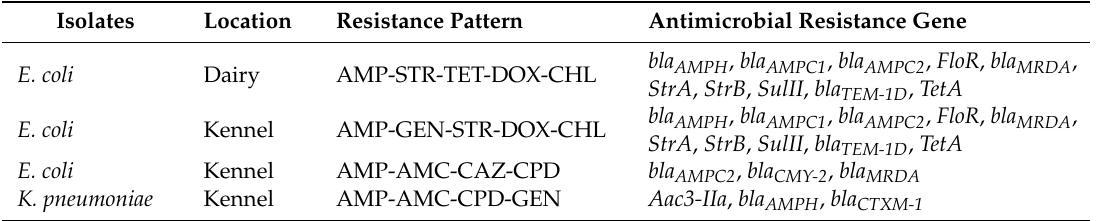
Table 5. Antimicrobial-resistant genes identified in multidrug-resistant isolates.